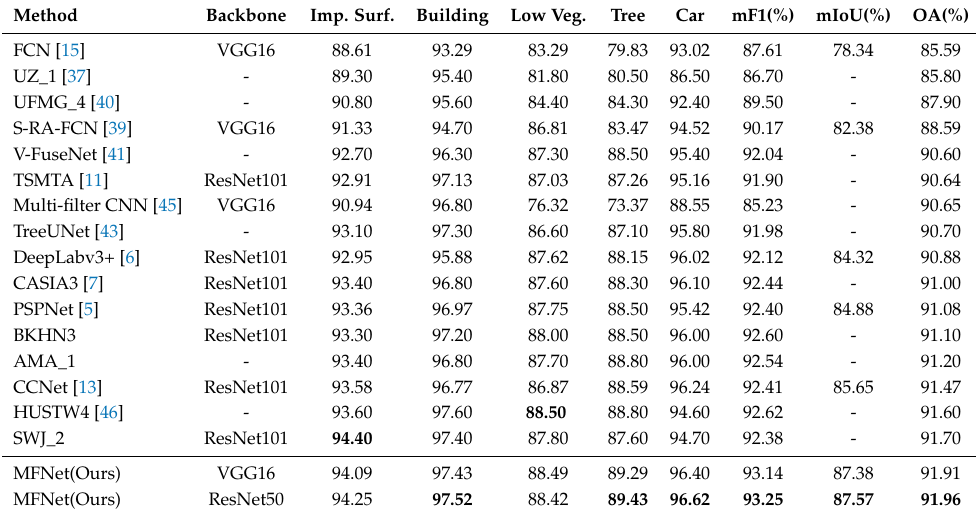
Fig. 9: visualize the results of Potsdam dataset. Figure 9. Visualization of the results of the Potsdam dataset. Notably, the baseline is FCN. Table 12. Comparisons with state-of-the-art on Potsdam test set. Method Backbone Imp. Surf. Building Low Veg.